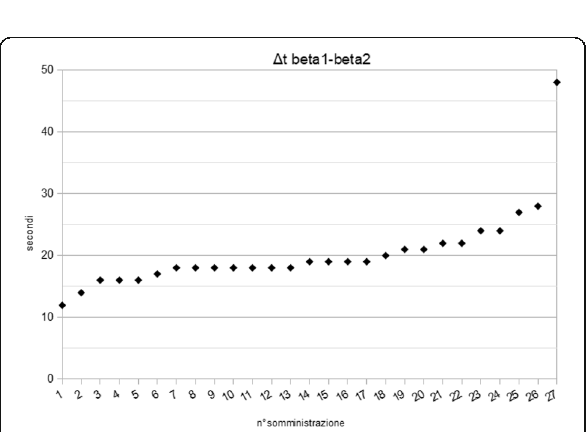
Fig. 2 (abstract A16). Interaction etilefrine-doxazosin